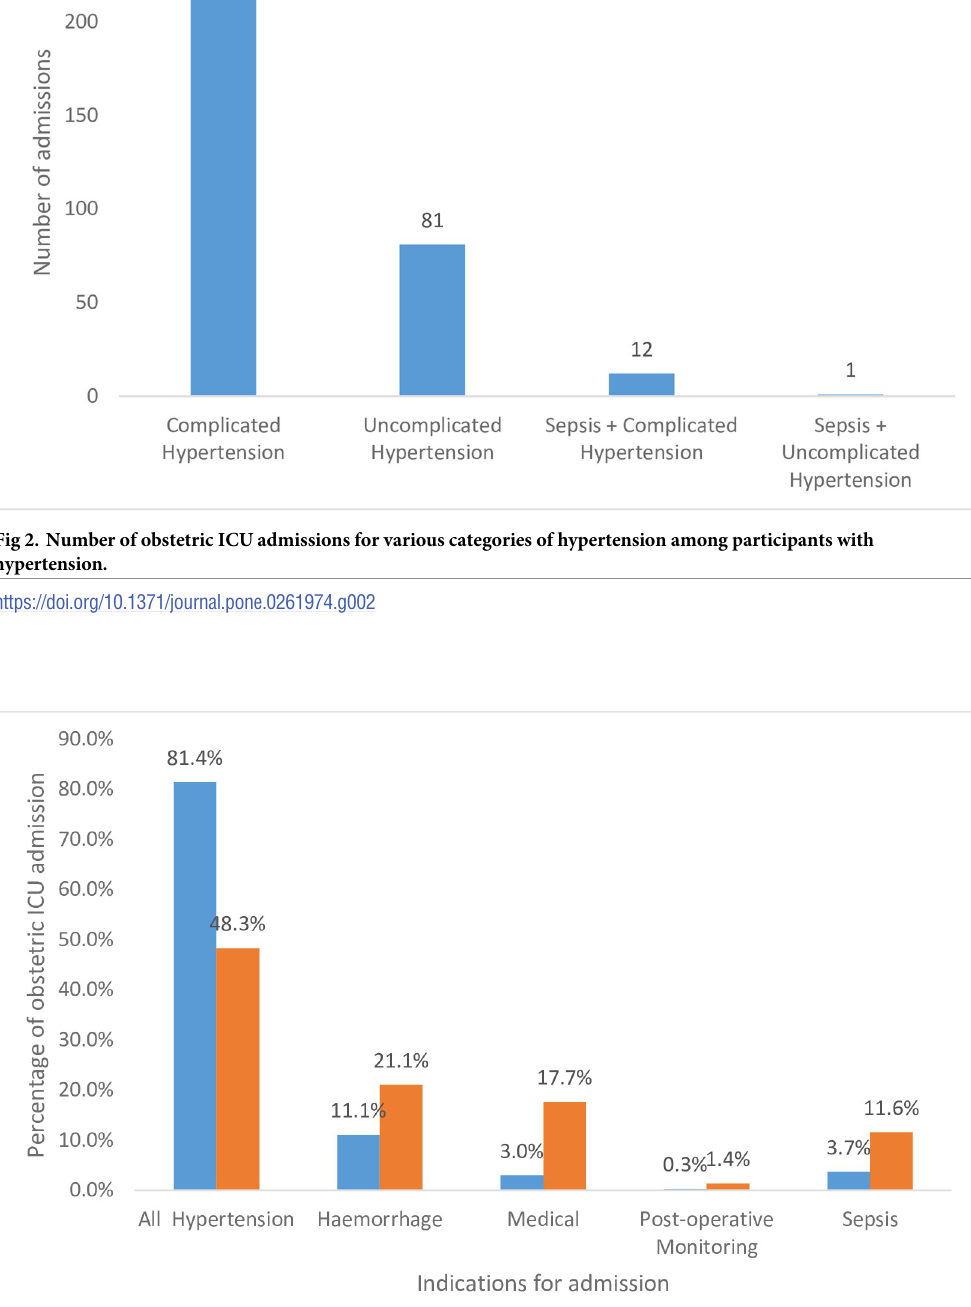
PLOS ONE | https://doi.org/10.1371/journal.pone.0261974 December31, 2021 8 /